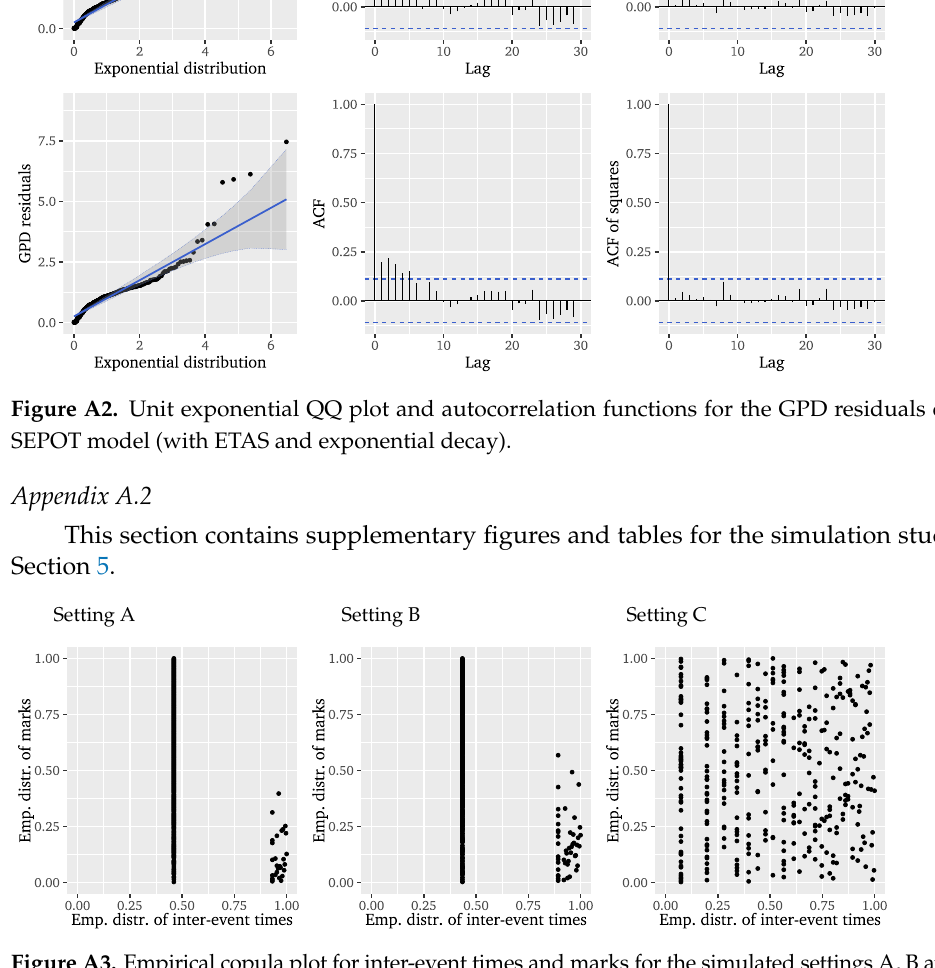
Figure A3. Empirical copula plot for inter-event times and marks for the simulated settings A, B and C. Table A1. Estimation results of the ARFIMA ( p , d , q ) model for the simulated settings A, B, and C. Standard errors in